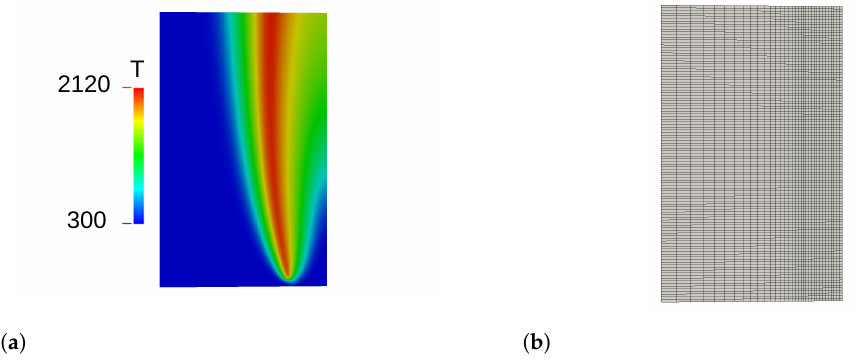
Figure 1. Diffusion lifted flame temperature field ( a ) and representation of the numerical grid ( b